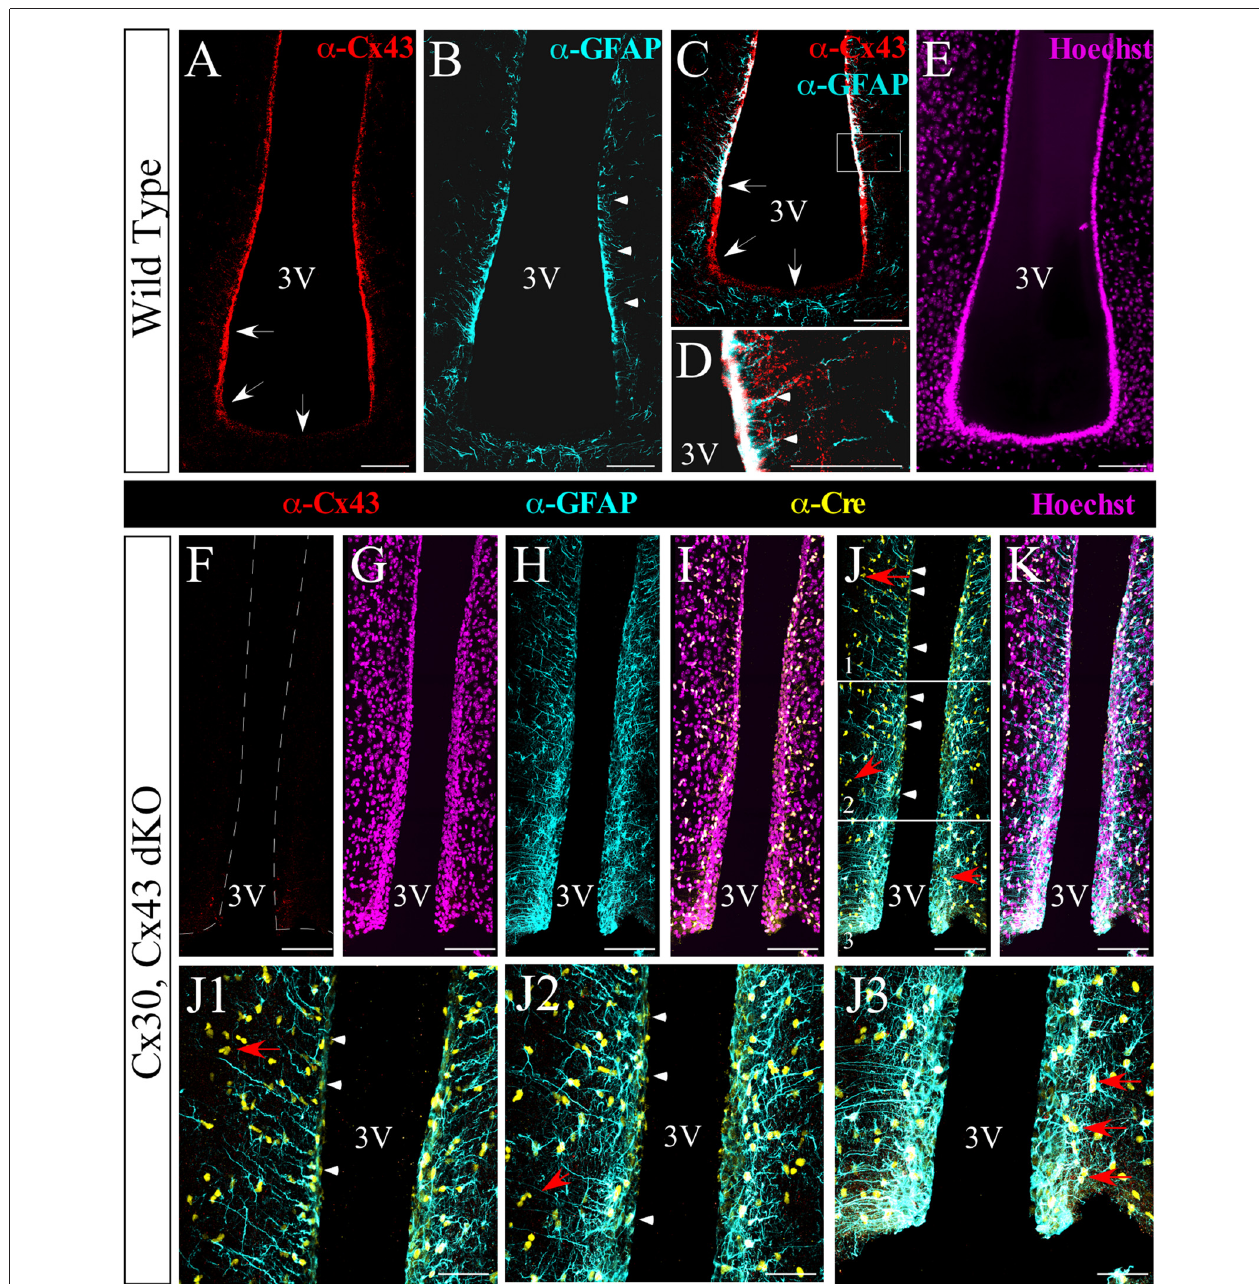
FIGURE 2 | Absence of hypothalamic Cx43 expression in double knockout (dKO) mice. Immunohistochemical analysis of frontal hypothalamic slices obtained from wild-type (WT; A–E ) and dKO (F–J3) mice. The expression of Cx43 is shown in red, glial fibrillary acidic protein (GFAP) in cyan, and Cre recombinase in yellow; nuclei staining is shown in the magenta channel. Arrowheads in (B,D) indicate the boundary of GFAP expression and the co-localization of GFAP and Cx43 in the lateral wall of the 3V. Arrows in (A,C) show the expression of Cx43 in α -tanycytes and its absence or weaker expression in β -tanycytes. (F–K) Images of the ventricular area using the markers as described. (J1–J3) Images are higher magnifications of ( J ; white frames) from the dorsal to the ventral portion. Panels (J,J1,J2) indicate the expression of Cre recombinase in some tanycytes (arrowheads). Red arrows in the ventral region (J,J1–J3) point to the expression of Cre recombinase by astrocytes. 3V, third ventricle. Scale bar (A–K) : 100 µ m. Scale bar (J1–J3) : 50 µ m.